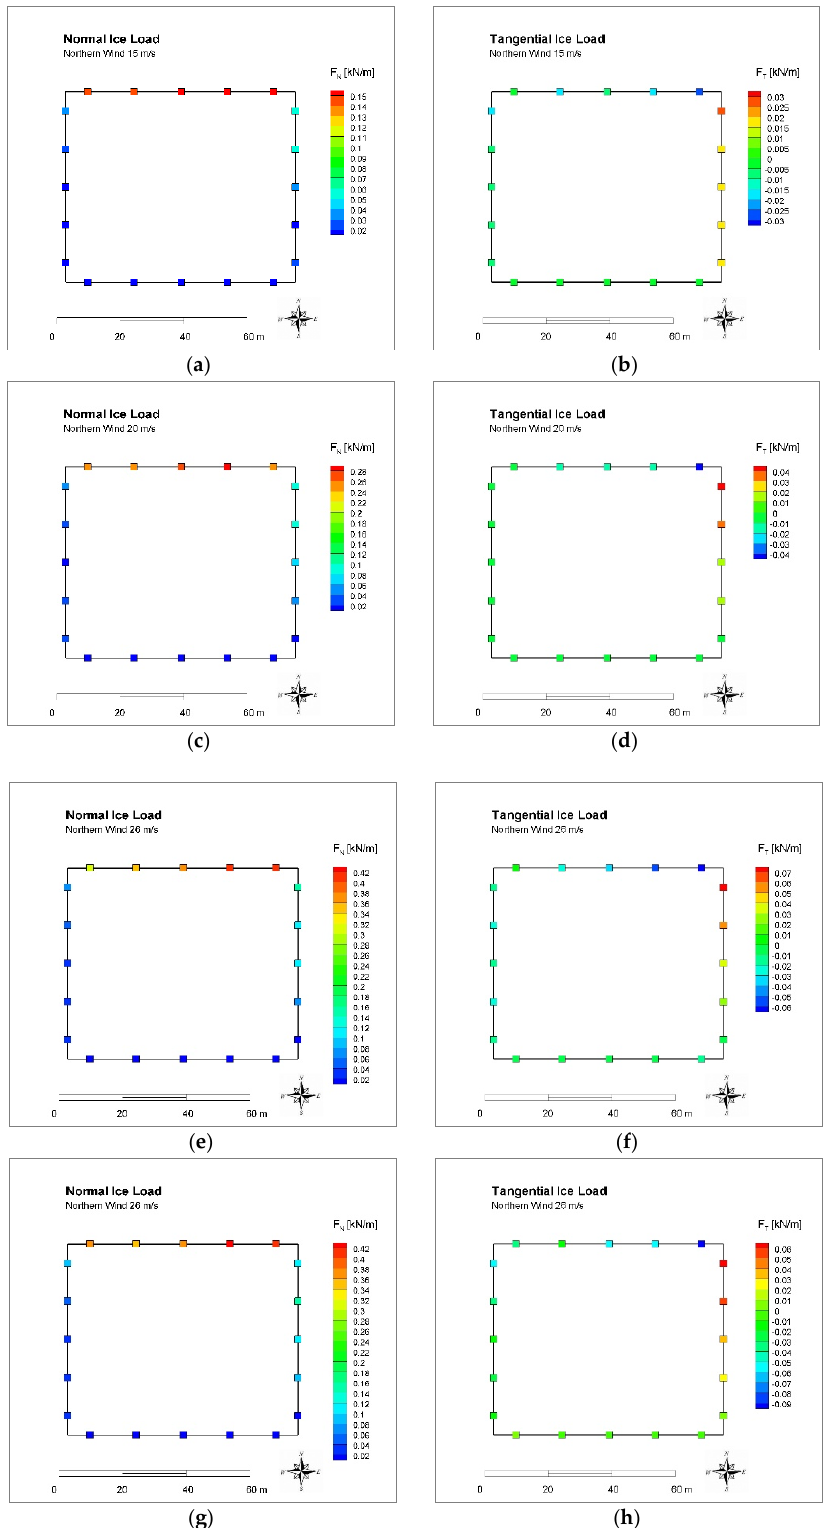
Figure 8. Normal and tangential ice load per meter imposed on structure edges based upon different wind velocities; shapes ( a – f ) represents numbers for 1 m, and ( g , h ) 2 m pool level reduction. Table 3 indicates the numbers for both normal and tangential forces placed on differ- ent edges of the structure. Figure 9 demonstrates the magnitude and direction of the force vectors placed on the structure edges for 26 m/s wind velocity. Regarding Table 3, it can be concluded that in the case of wind speed of 26 m/s, there is more fluctuation in the force